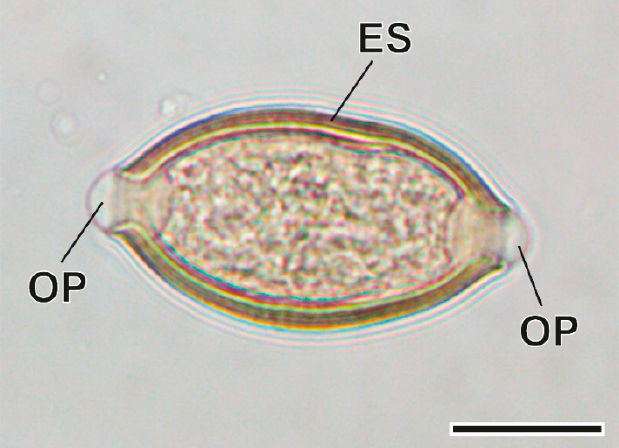
Figure 6. Egg of Trichuris arvicolae . ES, eggshell; OP, opercular plugs. Scale bar = 25 µm.